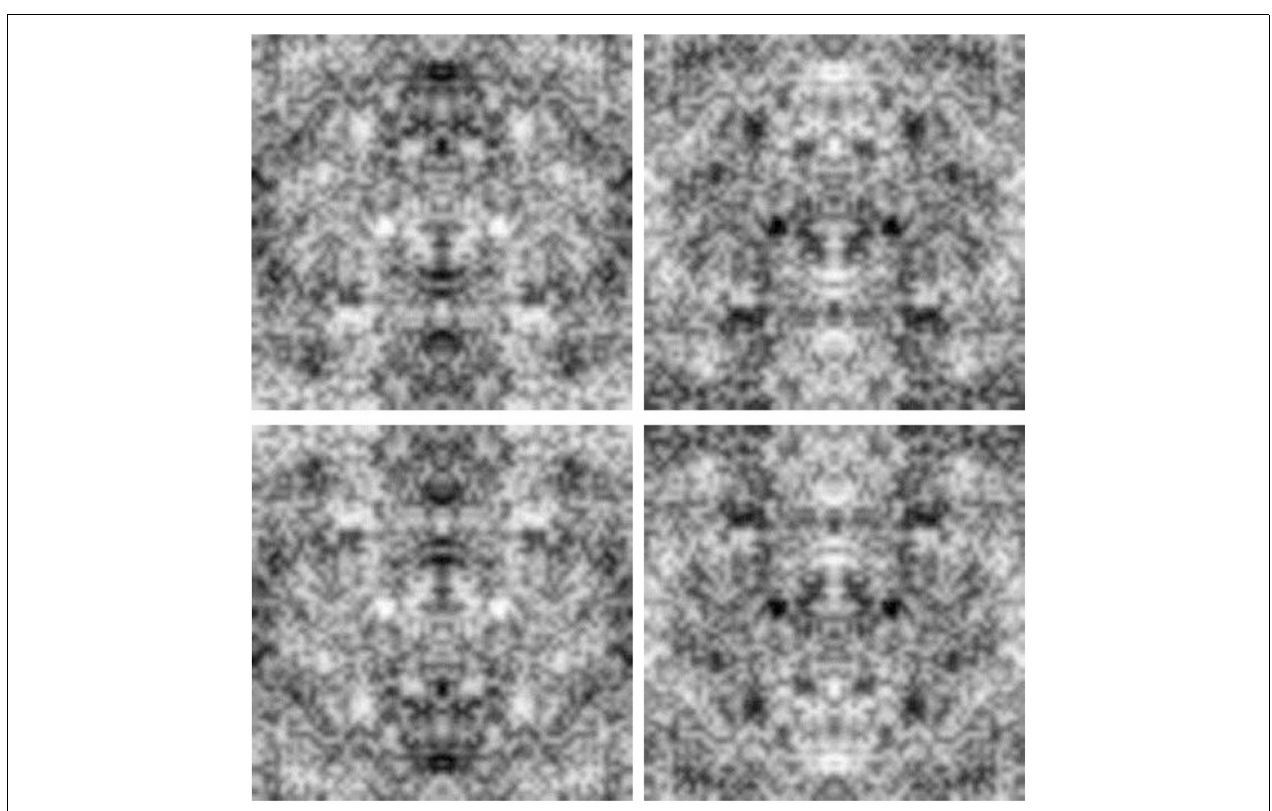
the same image with the contrast inverted; the bottom left with the orientation flipped; and the bottom right with both the orientation and the contrast inverted.